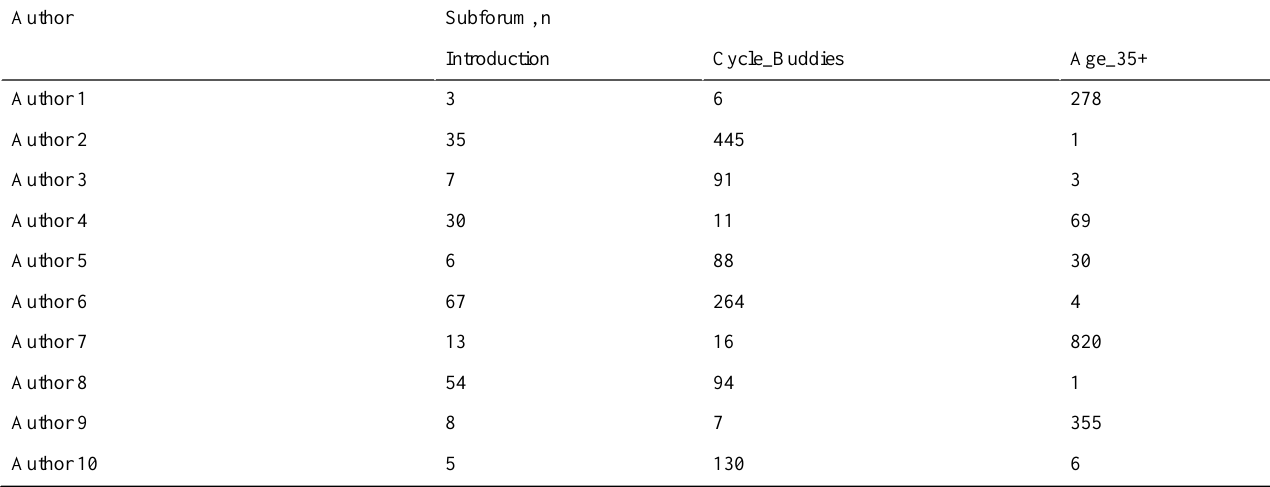
Table 2. Statistics for authors and distribution of their posts per